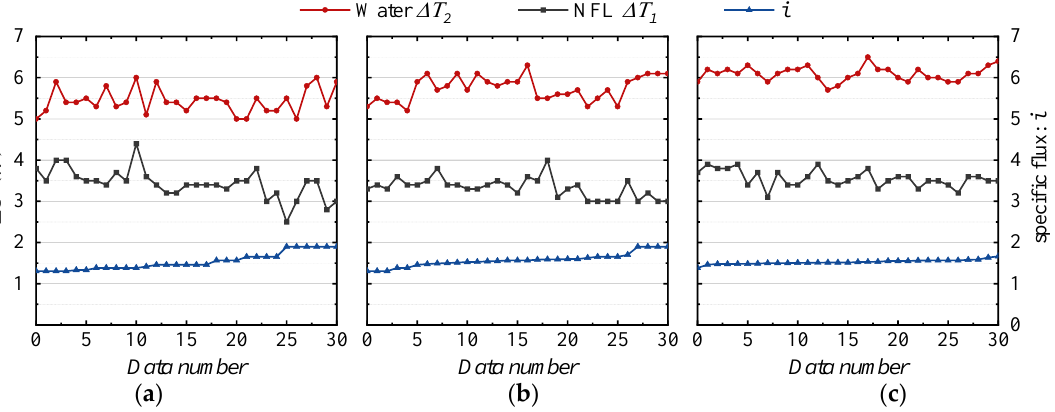
Figure 6. Heat transfer temperature difference Δ T and specific flux i at different outlet water temperatures T 2, out . ( a ) T 2, out : −2.0 °C. ( b ) T 2 , out : −2.5 °C. ( c ) T 2, out : −3.0 °C.